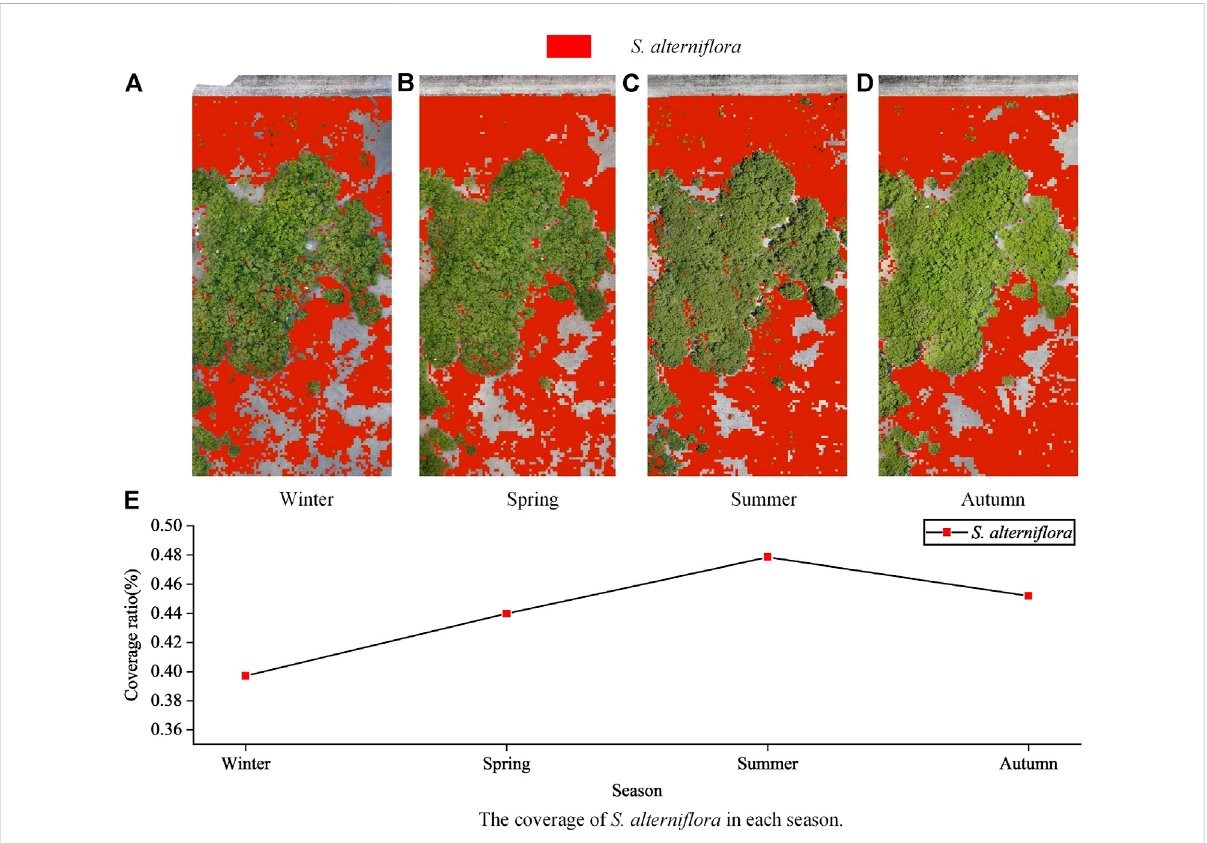
(Figure 8B). For tidal fl at identi fi cation, regardless of the model used, as long as the dataset used for training does not contain a dataset of a certain season, the model will not perform well in tidal fl at identi fi cation in that season. Even if the D model includes data from the four seasons, its average F1-score is still lower than 90%, which may be because in different seasons, the characteristics of tidal fl ats change greatly under the interference of environmental factors such as sunlight and tides. This will cause great interference in the accurate identi fi cation of tidal fl ats (Figure 8C). For the identi fi cation of seawalls, in the single- season model (A1-A4) and the two-season model (B1-B4), except for the A3 model, the average F1-score was 68.26%, and the rest were all higher than 80%. The average F1-score was above 90% in both the C1-C4 and D models, with the D model being the highest at 96.85%. The identi fi cation of seawalls was greatly improved by combining multiseason data (Figure